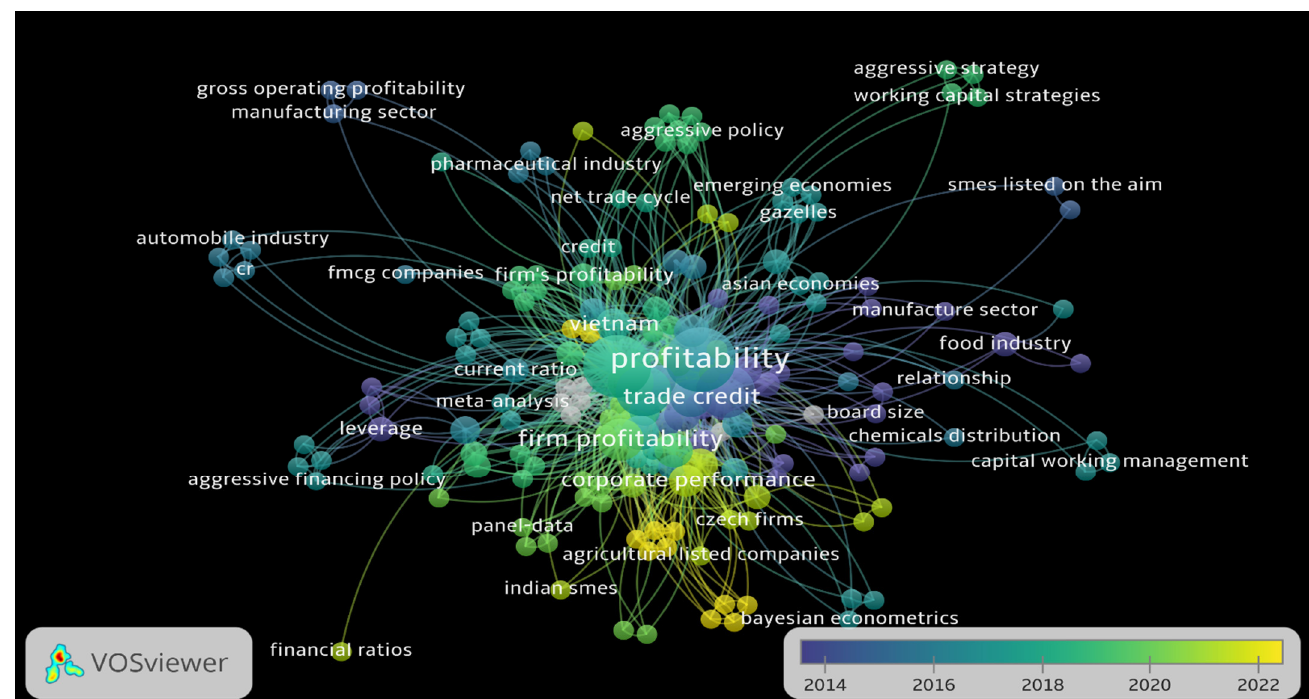
Figure 2. Bibliographic analysis II.